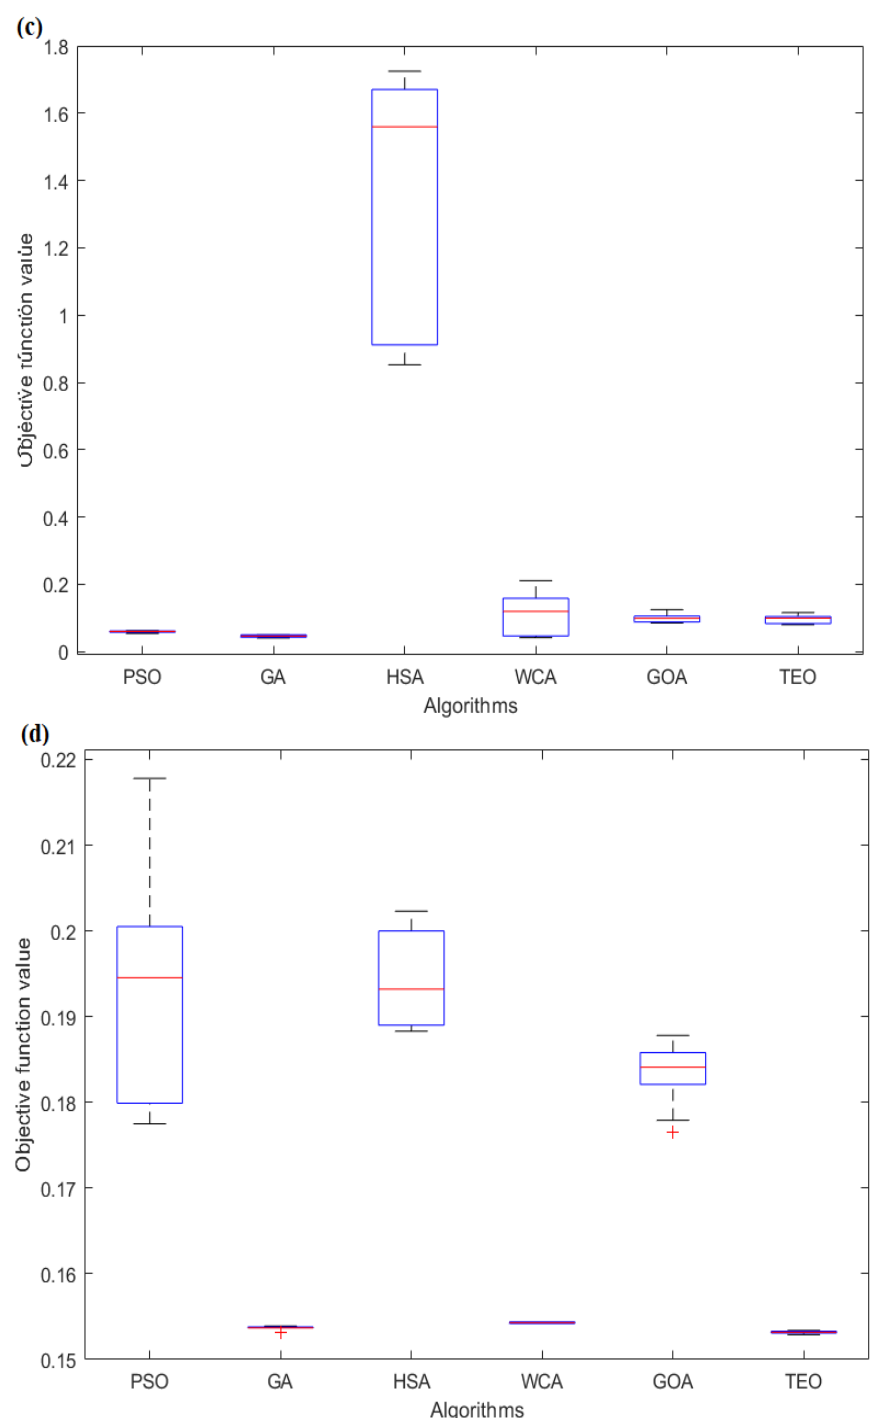
Figure 5. Box-and-whisker plot: ( a ) IAE; ( b ) ISE; ( c ) ITAE; ( d ) ITSE index.